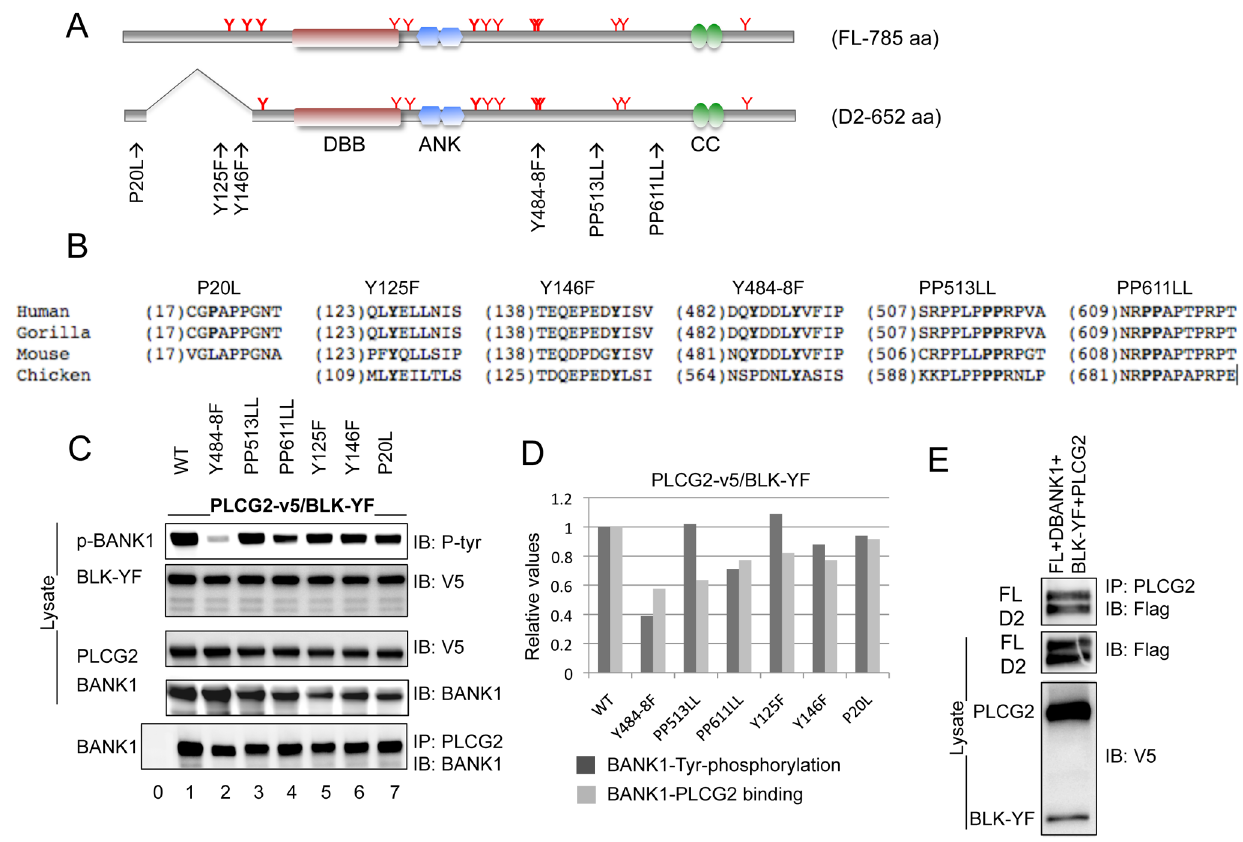
Figure 6. Mutations of specific tyrosine residues and proline rich domains of BANK1 abrogated the association with PLCg2. (A) Schematic representation of the motifs and the structure of the human BANK1 splicing variants and analysis of the motifs affecting the BANK1-PLCg2 binding. The Dof/BCAP/BANK (DBB) motif (amino acids 199–327), the double ankyrin repeat-like (ANK) motifs (amino acids 339–402) and the presumptive coiled coils (CC) region (amino acids 677–705) are indicated. Tyrosine residues susceptible to be phosphorylated are shown by Y. Residues Y125, Y146, Y161, Y416, Y484 and Y488 that predict the putative SH2 binding sites are indicated as bold Y (http://scansite.mit.edu/ motifscan_seq.phtml). The positions of the mutated amino acids are indicated above the BANK1 drawing. (B) Alignment of the BANK1 amino acid motifs in different species indicating the mutated residues corresponding to putative SH2 and SH3 binding domains, alignment was done using data downloaded from www.ensembl.org. (C) Phosphorylation and immunoprecipitation analysis of the wild type and mutated forms of BANK1 co- expressed with the constitutively active form of BLK (BLK-YF) and PLCg2. Relative expression of the constructs was monitored by western blot (IB) of an aliquot (1/10) of the transfected HEK293T cell extract. The rest of the lysates were used for immunoprecipitation (IP) using anti-PLCg2 (Abcam) and it is shown in the lower row. Lane 0 represents immunoprecipitation without the IP antibody. (D) Quantification of BANK1 phosphorylation and immunoprecipitation using anti-PLCg2 antibody. Bands of the western blots were quantified using ImageJ program. Values of expression of BANK1 in the lysates (IB:Anti-BANK1) were taken to normalize the results of phosphorylation and immunoprecipitation of BANK1. The relative expression of BANK1 was: 1, 1.03, 0.93, 0.85,0.69, 0,81, and 0.73 from lane 1 to 7 in the lysates interrogated with anti-BANK1. The Y484-8F mutation significantly reduced both the tyrosine phosphorylation of BANK1 and the binding to PLCg2. The PP513LL mutation does not affect the tyrosine phosphorylation of BANK1, however it leads to a decrease in binding to PLCg2. (E) Co-expression in HEK293T cells of the two isoforms of BANK1 renders equivalent recovery of both isoforms in the anti-PLCg2 immunoprecipitate, indicating that exon 2 did not participate in the binding between BANK1 and PLCg2.